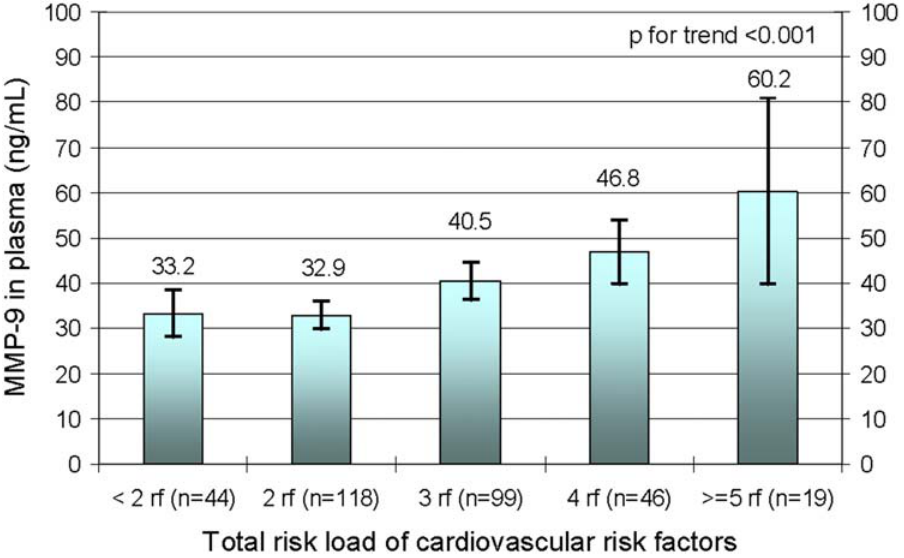
Figure 1. MMP-9 in relation to total risk load. Dichotomies of eight risk factors are taken into account in the analysis: n=326 with full information on every variable. Blood pressure (SBP . 160 and/or DBP . 100 mm Hg and/or using antihypertensive agents, n=81), LDL/HDL (ratio . 3, n=54), obesity (BMI . 30, n=67), diabetes (yes, n=22), smoking (yes, n=57), alcohol intake ( . 170 grams/week, n=37), low physical activity (all other than top ordinal category, n=272), low fruit and vegetables intake (all other than top ordinal category n=307). Mean and 95% confidence